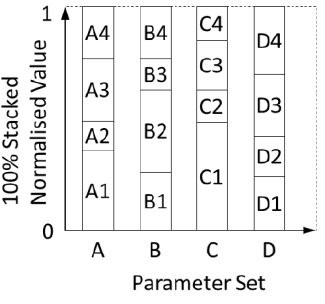
Figure 5 Parameter spectrum as 100% stacked normalised parameter sets.